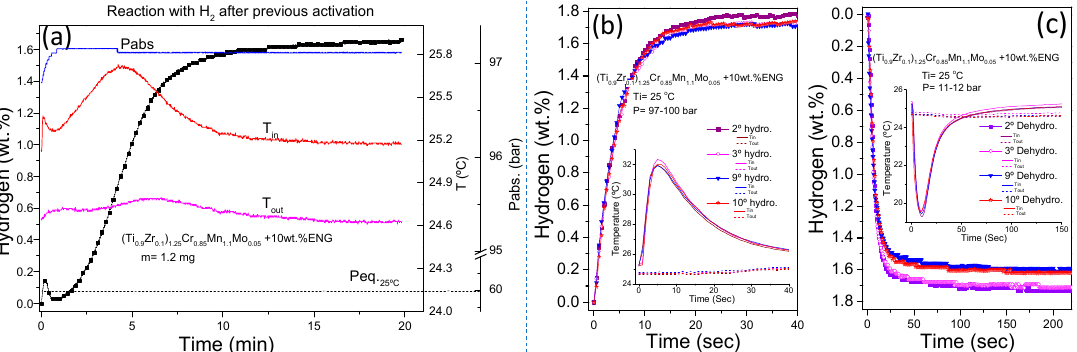
Figure 6. ( a ) First active hydrogenation of (Ti 0.9 Zr 0.1 ) 1.25 Cr 0.85 Mn 1.1 Mo 0.05 + 10 wt.% ENG under around 100 bar and 25 °C, and ( b ) hydrogenation and ( c ) dehydrogenation cycling under 97–100 bar and 11–12 bar for (Ti 0.9 Zr 0.1 ) 1.25 Cr 0.85 Mn 1.1 Mo 0.05 + 10 wt.% ENG (m = 1.2 g, Sieverts apparatus [62]).